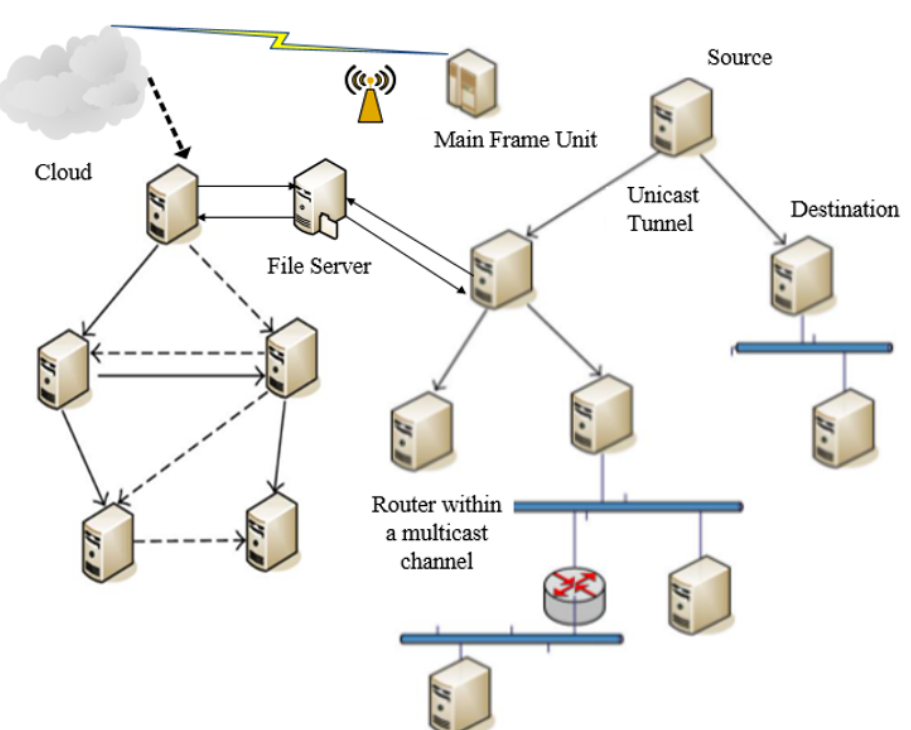
Figure 3. A generic mesh-based overlay tree